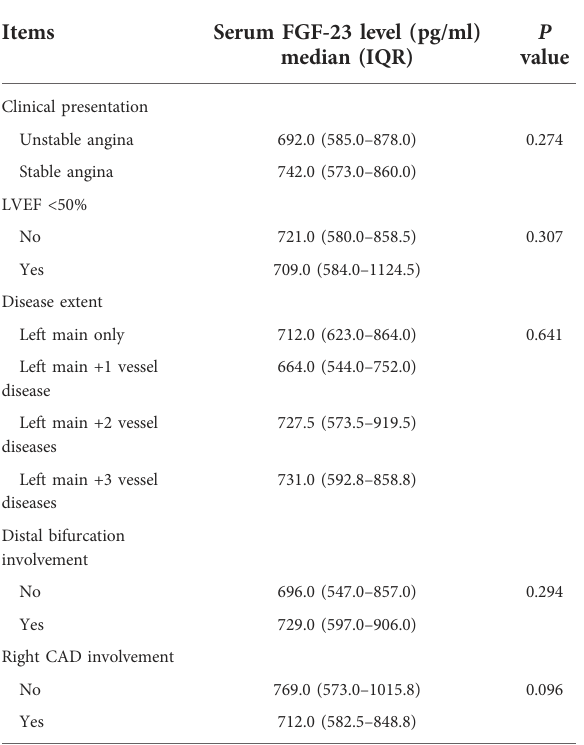
According to the median value of ULMCAD patients ’ FGF- 23 level at discharge, they were divided into FGF-23 (at discharge) high and low groups. It was found that the cumulative MACCE rate was increased slightly in FGF-23 (at